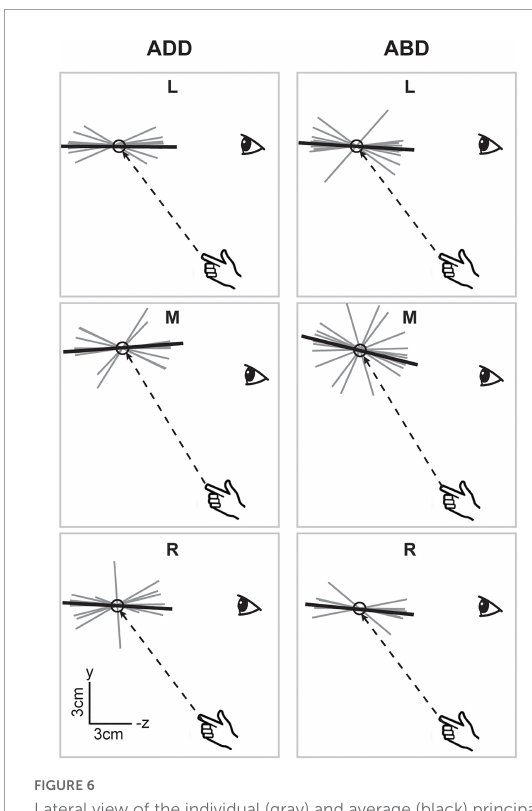
FIGURE7 Lateral view of the individual and average principal axes of variability in the NV condition. Figure conventions follow those of Figure 6 . In some cases (e.g., ADD L), average axes were roughly aligned with the approximated sight lines to the targets. More generally however axes were pitched upward, reminiscent of previous findings for memory-guided reaches (Mcintyre et al., 1997, 1998). Similar to the V condition, the axis for the middle target appeared to rotate downward as arm posture changed from ADD to